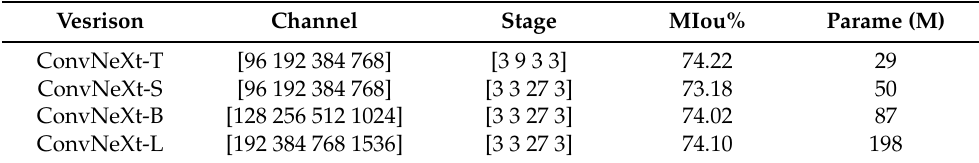
Table 2. Performances of different versions of ConvNext.